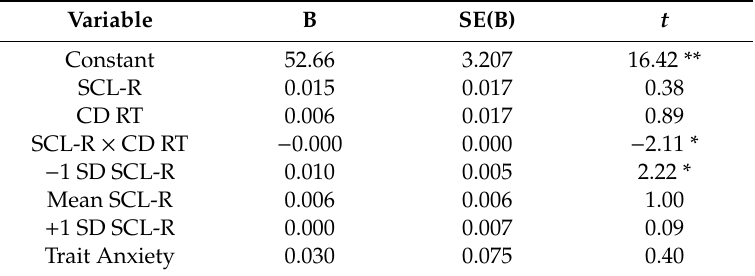
Table 3. Moderation by Initial SCL Reactivity (SCL-R) of the Relation between the Change Detection Reaction Time and O-Span Recall, Controlling for Trait Anxiety.